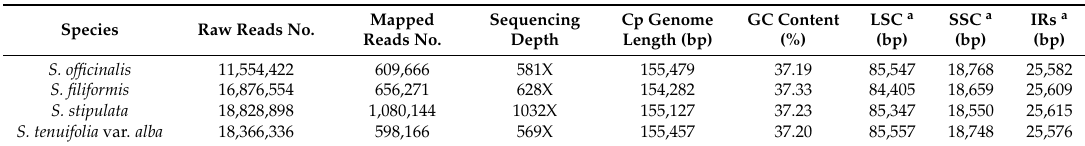
Table 1. Sequence information and Illumina next-generation sequencing (NGS) data of the four Sanguisorba chloroplast genomes. Mapped Sequencing Species Raw Reads No. Reads No.